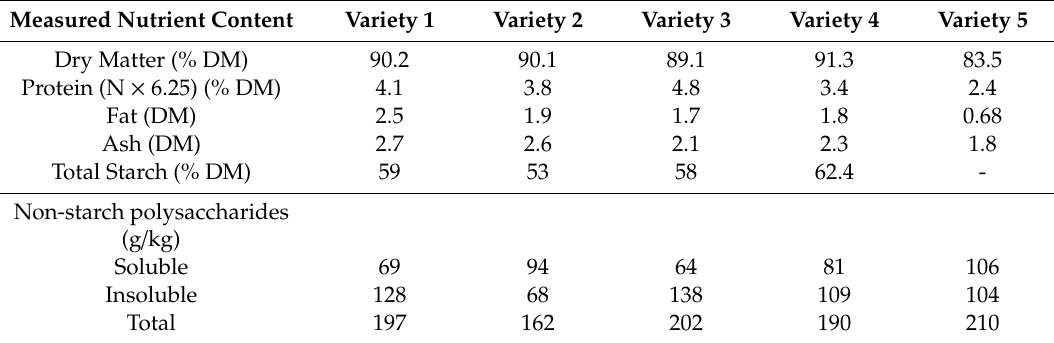
Table 2. Chemical composition of 5 local Papua New Guinea (PNG) Sweetpotato cultivars. Measured Nutrient Content Variety